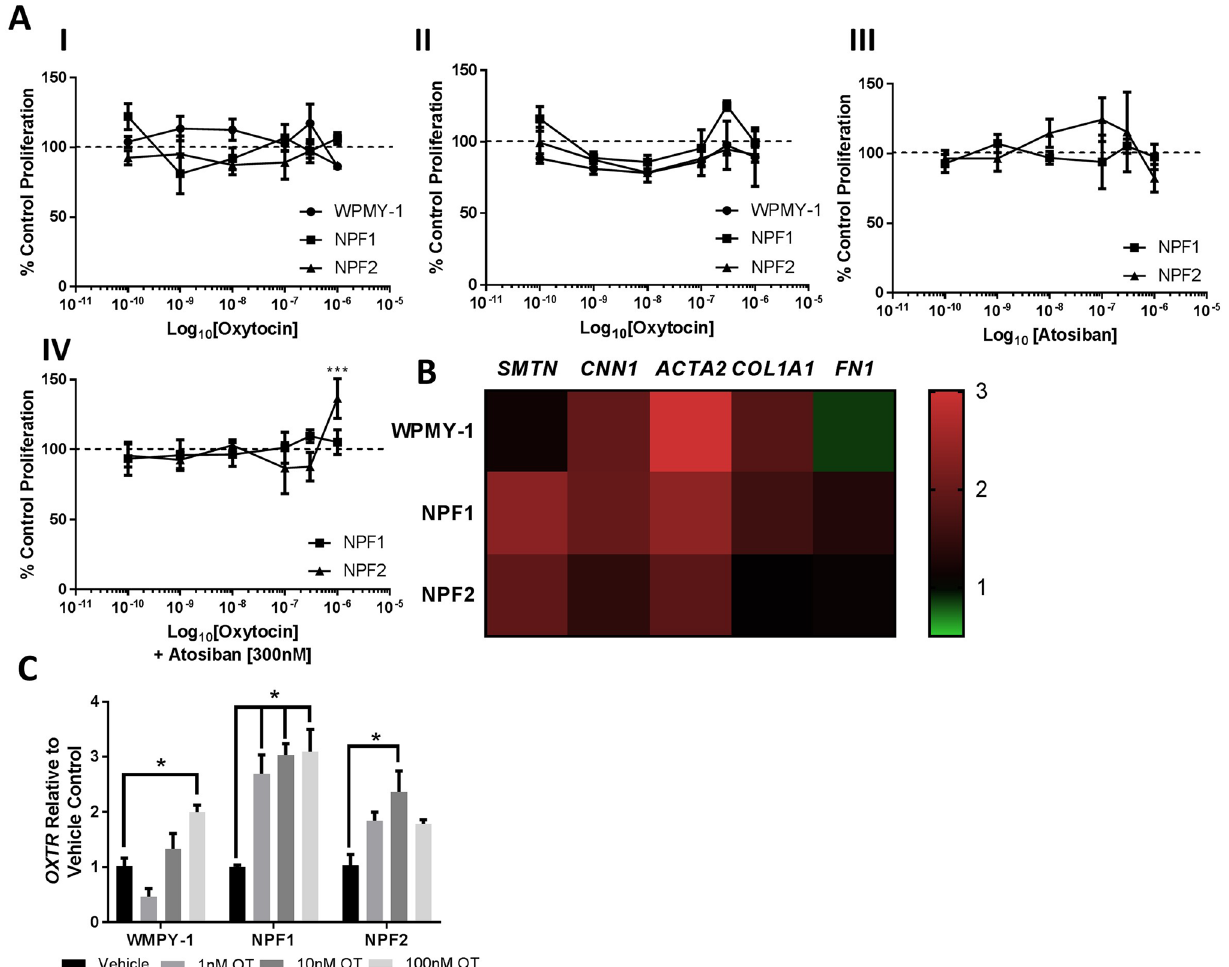
Figure 2. Exogenous oxytocin did not induce proliferation of stromal cells in culture. ( A ) To assess the static component, isolated primary patient derived non-malignant (NPF1 and NPF2) and immortalised (WMPY1) human prostate fibroblasts were exposed to (I) exogenous oxytocin (0.1 nM–1 μM) for 72 h, exogenous oxytocin (0.1 nM–1 μM) for 120 h (III) the OXTR antagonist Atosiban (0.1 nM–1 μM), or (IV) increasing concentrations of exogenous oxytocin (0.1 nM–1 μM), in the presence of Atosiban (300 nM) in culture for 72 h, following which proliferation was assessed using Cell Titre 96 Aqueous One cellular proliferation assay, with